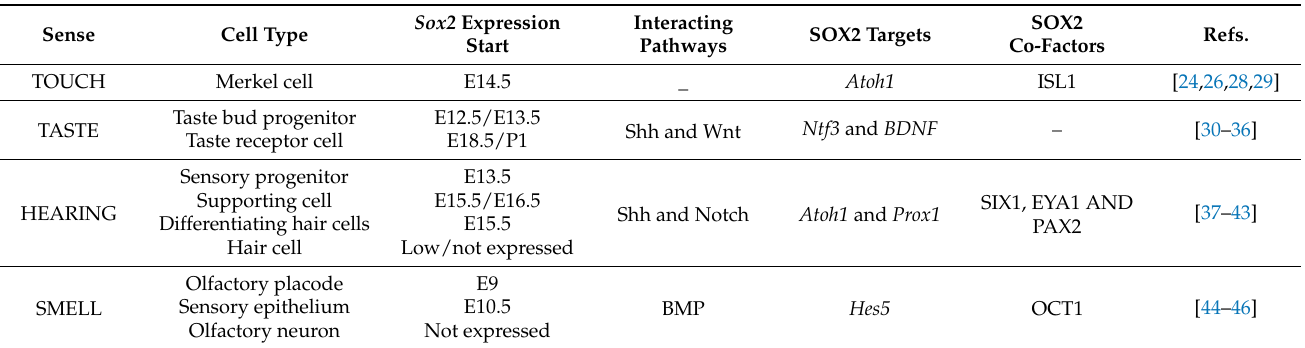
Table 1. SOX2 and sensory organs in